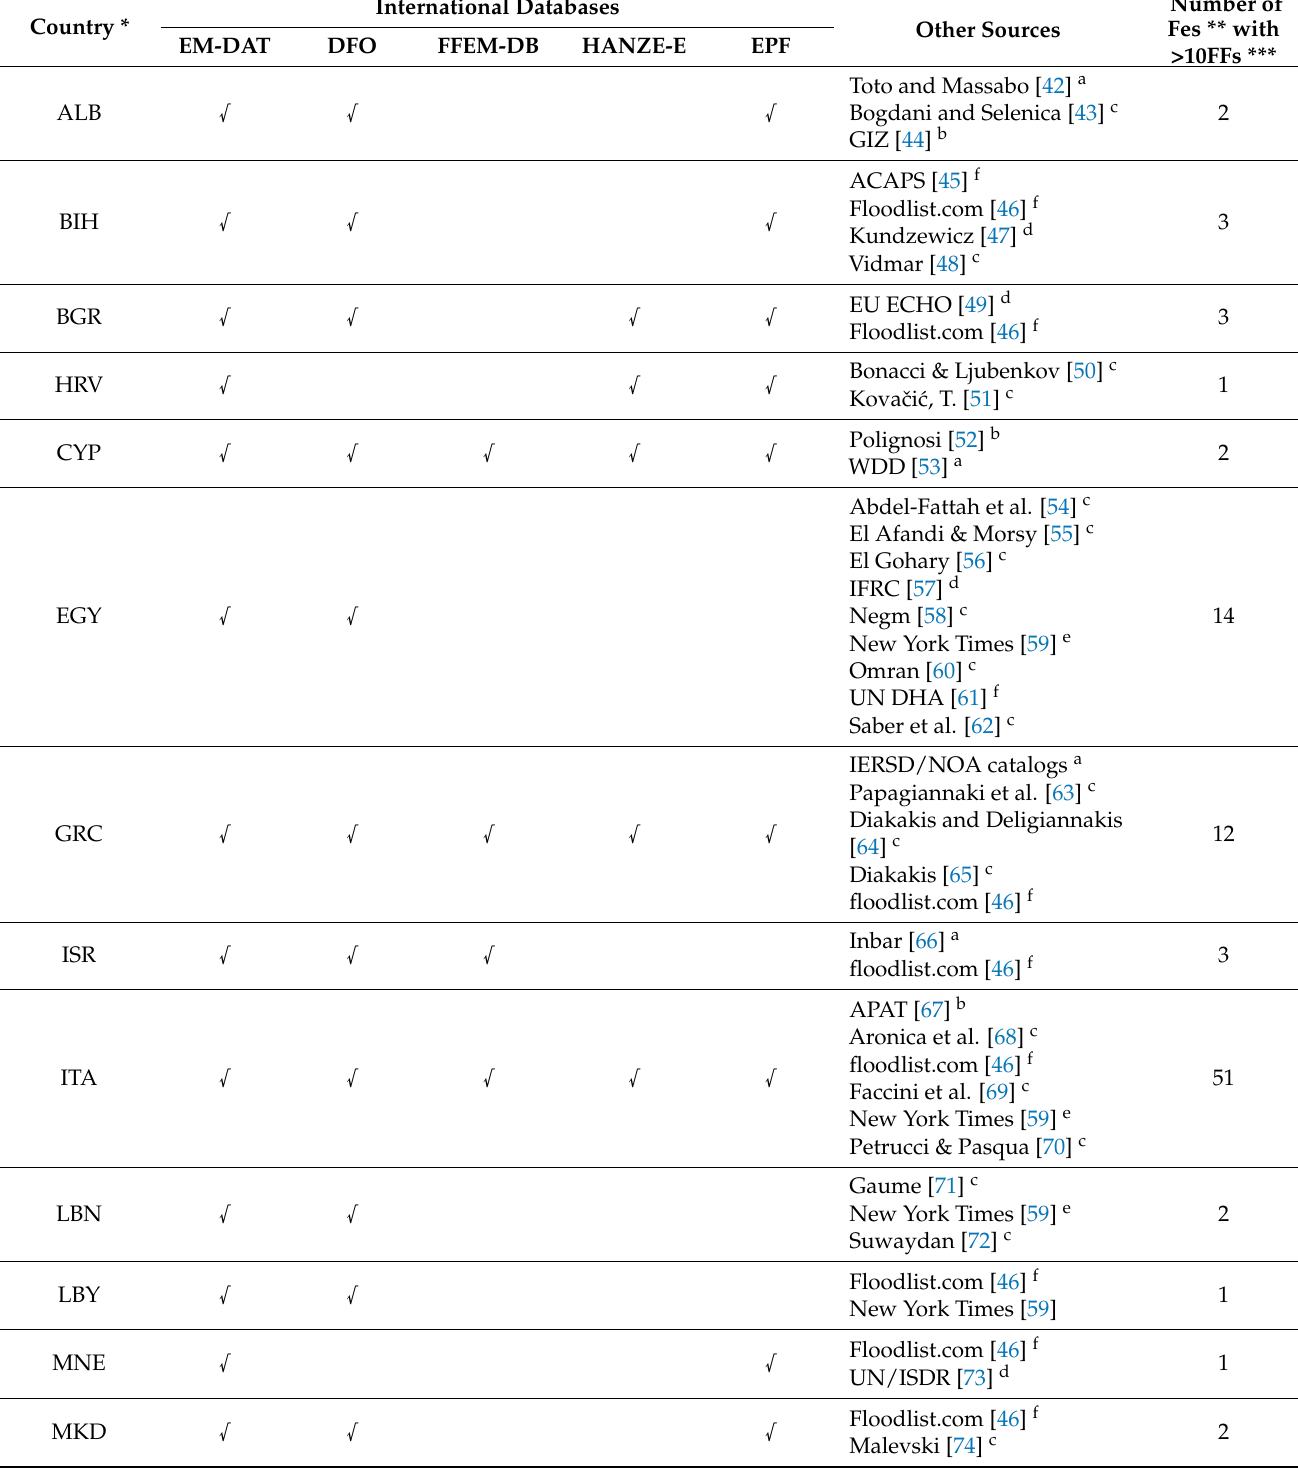
Table 1. Details on the data sources used for each country that is included in the database and the number of flash flood events